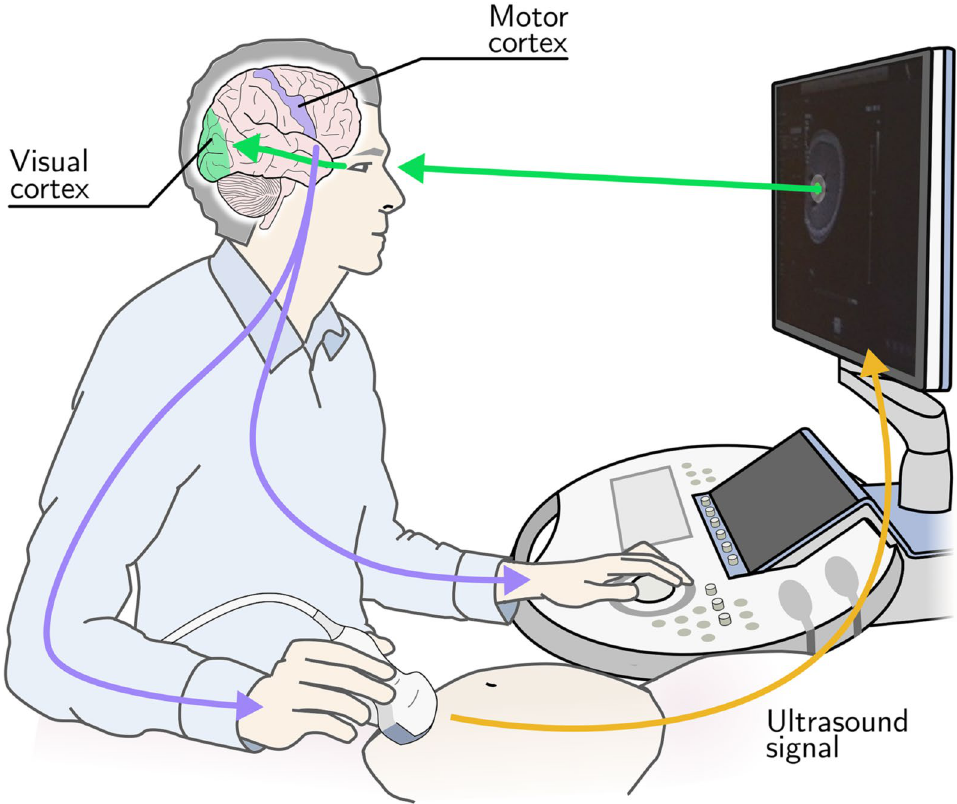
Figure 1. "Sonographer loop" is the process ultrasound sonographers undertake while acquiring standard planes: the sonographer gazes at the ultrasound screen, manipulates the hand to adjusts the transducer position which changes the displayed image, and back to sonographer looking at the monitor. Figure created using Inkscape version 0.92 (https:// inksc ape.